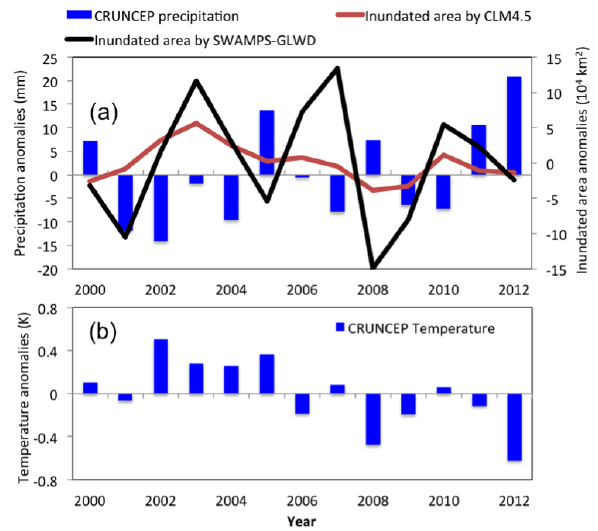
Figure 7. The anomalies of annual precipitation and inundated area in Alaska (a) and the anomalies of annual mean temperature (b) . The anomalies are calculated by subtracting the average between 2000 and